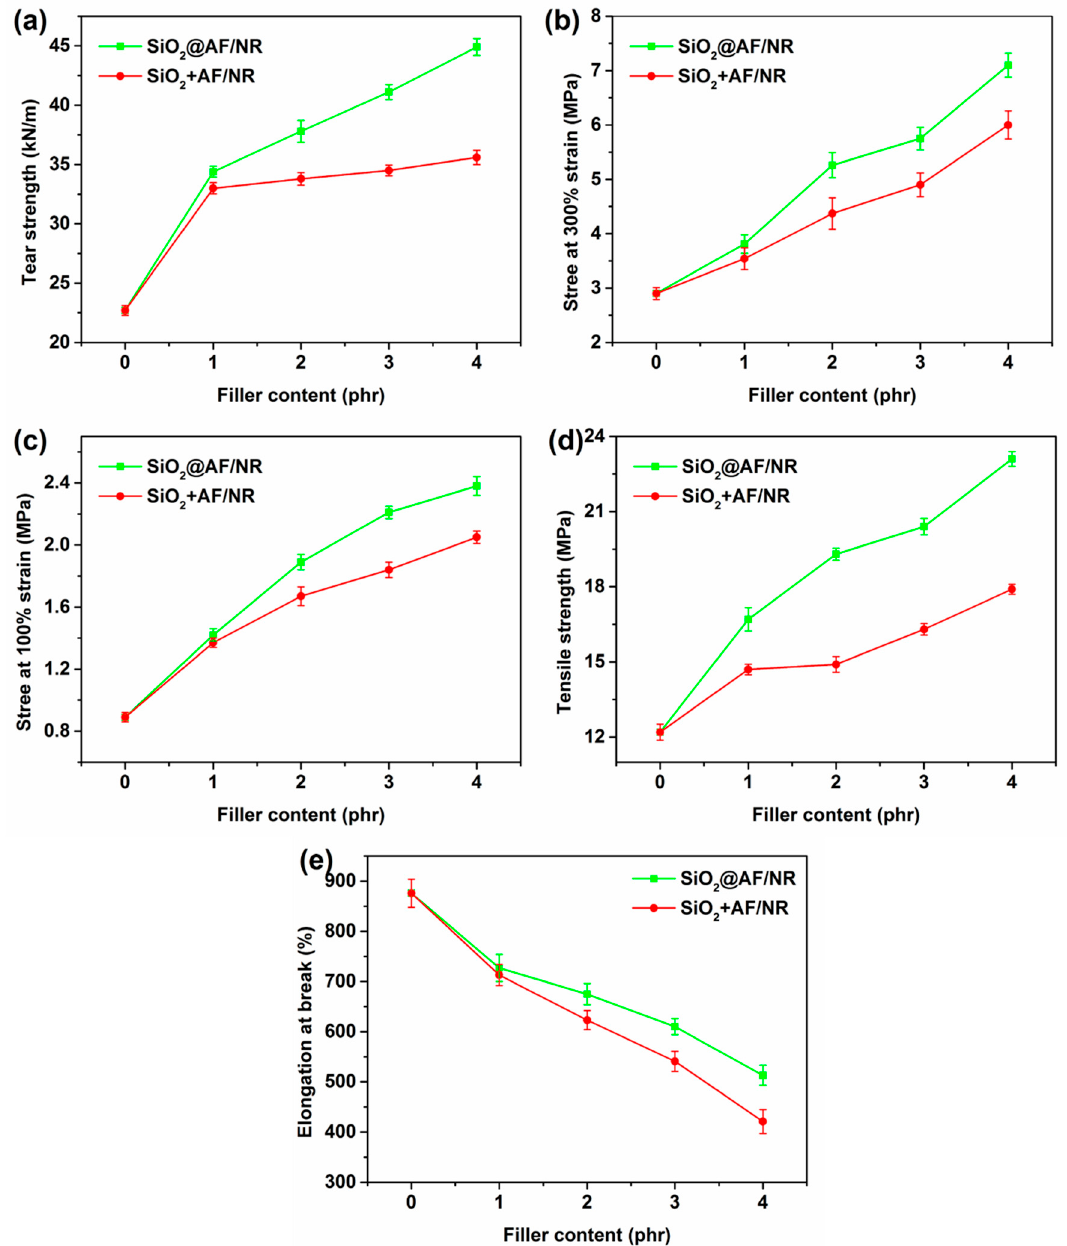
Figure 8. Tear strength ( a ), stress at 300% strain ( b ), stress at 100% strain ( c ), tensile strength ( d ) and elongation at break ( e ) of the neat NR and the SiO 2 +AF/NR and SiO 2 @AF/NR composites with different filler contents.